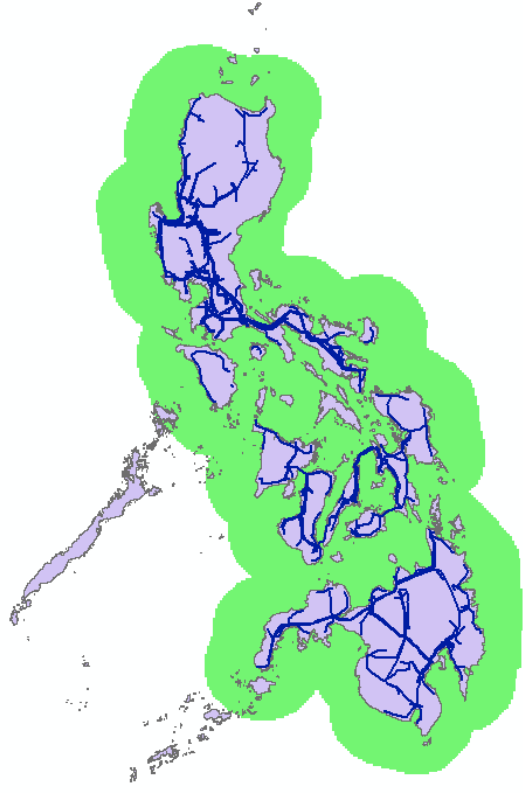
Figure 9. Distance to grid within 120